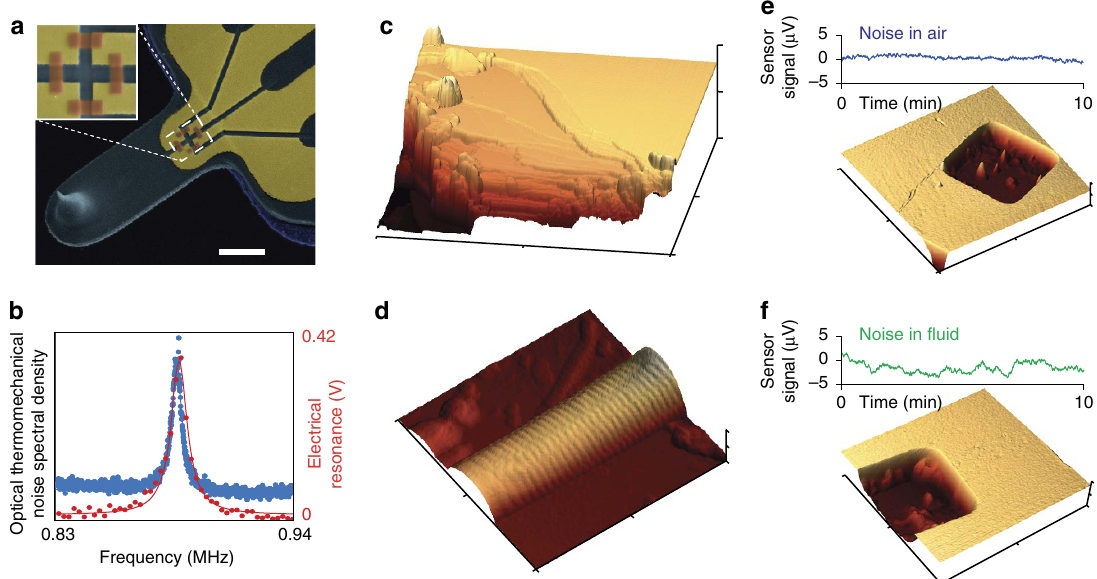
Figure 4 | Atomic force microscopy imaging using nanogranular tunnelling resistor active readout. ( a ) Scanning electron microscopy image of the SiN atomic force microscopy (AFM) cantilever for dual readout (dimensions: 20 (cid:4) 8 (cid:4) 0.3 m m 3 ). Inset: nanogranular tunnelling resistor (NTR) full bridge. Scale bar, 5 m m. ( b ) Driven resonance curve measured with NTR sensor (red) and optical thermal spectrum (blue). ( c ) AFM image of atomically flat steps on scratched mica. Total scan size: 5 (cid:4) 5 m m 2 . Topography height: 1 m m. ( d ) AFM image of rat-tail collagen fibril showing the characteristic 67nm spaced, 6nm high banding pattern. Total scan size: 2.1 (cid:4) 2.1 m m 2 . Topography height: 370nm. ( e , f ) Noise of NTR sensor in air ( e ) and PBS ( f ) with AFM image of a